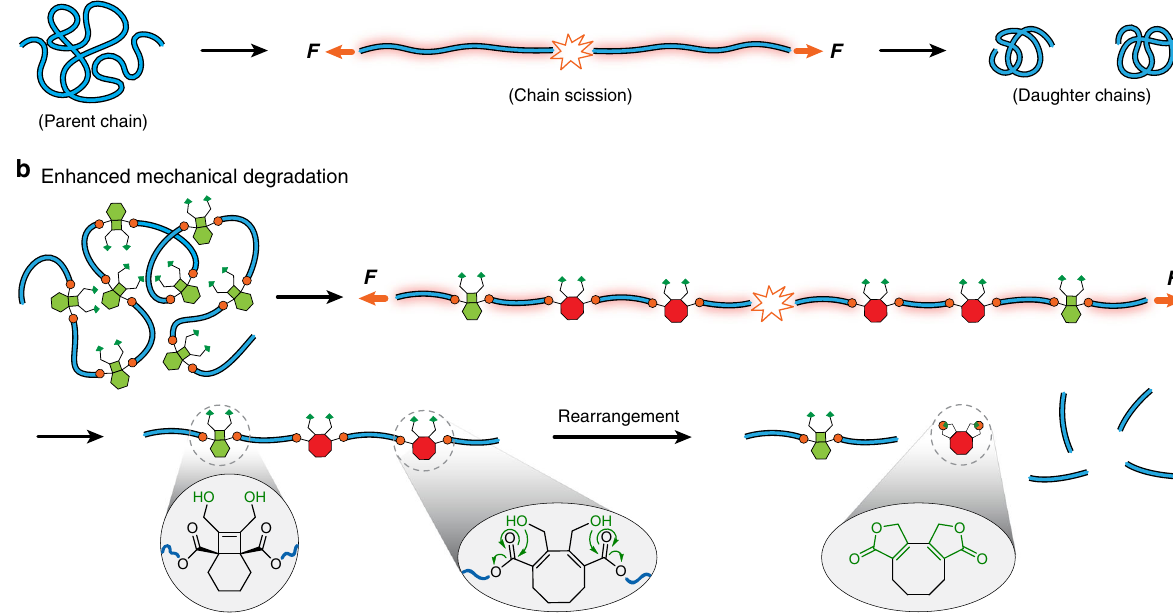
Fig. 1 Illustration of mechanically induced chain scission and design of enhanced mechanical degradation. a Subjection of polymer chain to mechanical force leads to chain scission at near midchain region and produces two daughter chains. b A polymer bearing BCOE mechanophores undergoes mechanically induced forbidden ring opening and subsequent lactonization rearrangement, leading to enhanced